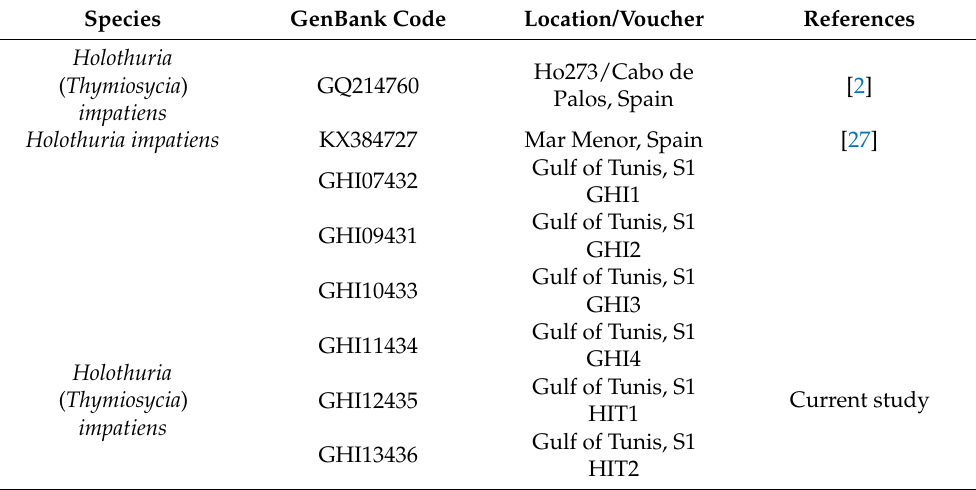
Table 2. Holothuria ( Thymiosycia ) impatiens individuals included in this study and analyzed for the partial cytochrome oxidase subunit 1 (COI) with references, GenBank accession numbers, and sample location. Species GenBank Code